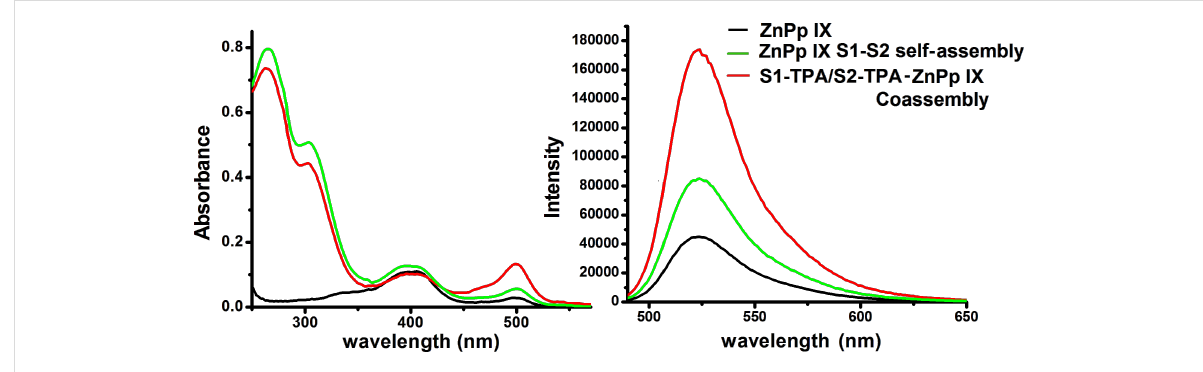
Figure 8: UV–vis absorption spectra and steady-state fluorescent spectra of rhodamine 123 quantifying the photocatalytic activity of nanofibers (S1 DNA–TPA/S2 DNA–TPA triconjugate Zn PpIX coassembly) and their control.